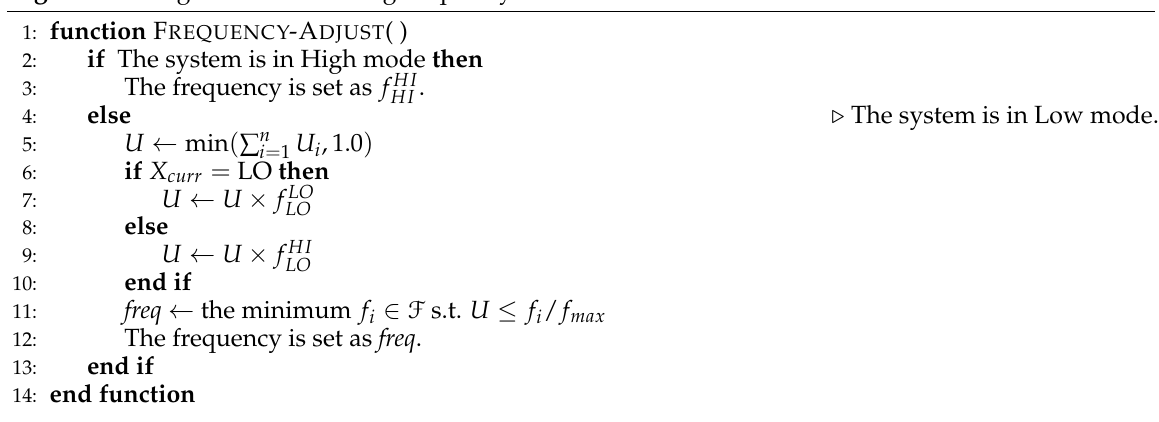
Algorithm 2 Algorithm of selecting frequency.